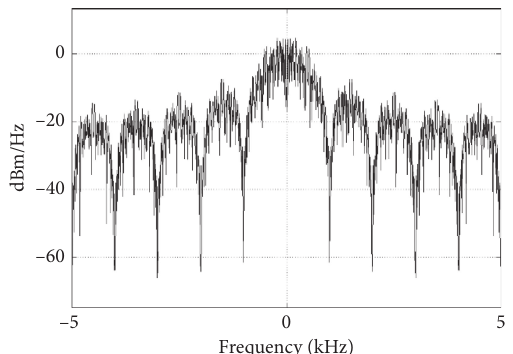
Figure 4: Power spectral of spread spectrum signal.